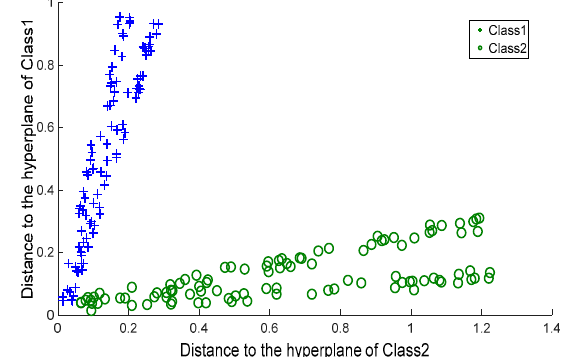
Figure 6. Twin Support Vector Machines: Distance values.